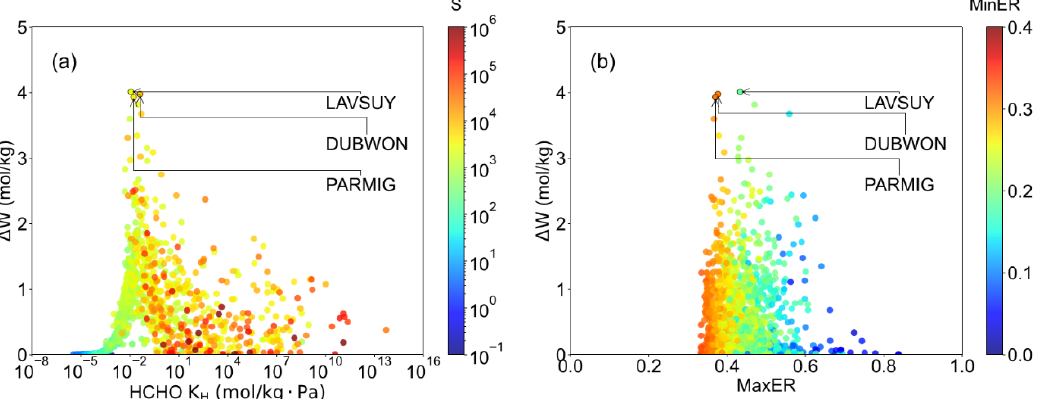
Figure 2. The relationship of formaldehyde capture performance and structural properties. ( a ) HCHO KH—working capacity relationship, colored by selectivity. ( b ) MaxER—working capacity relationship, colored by MinER.